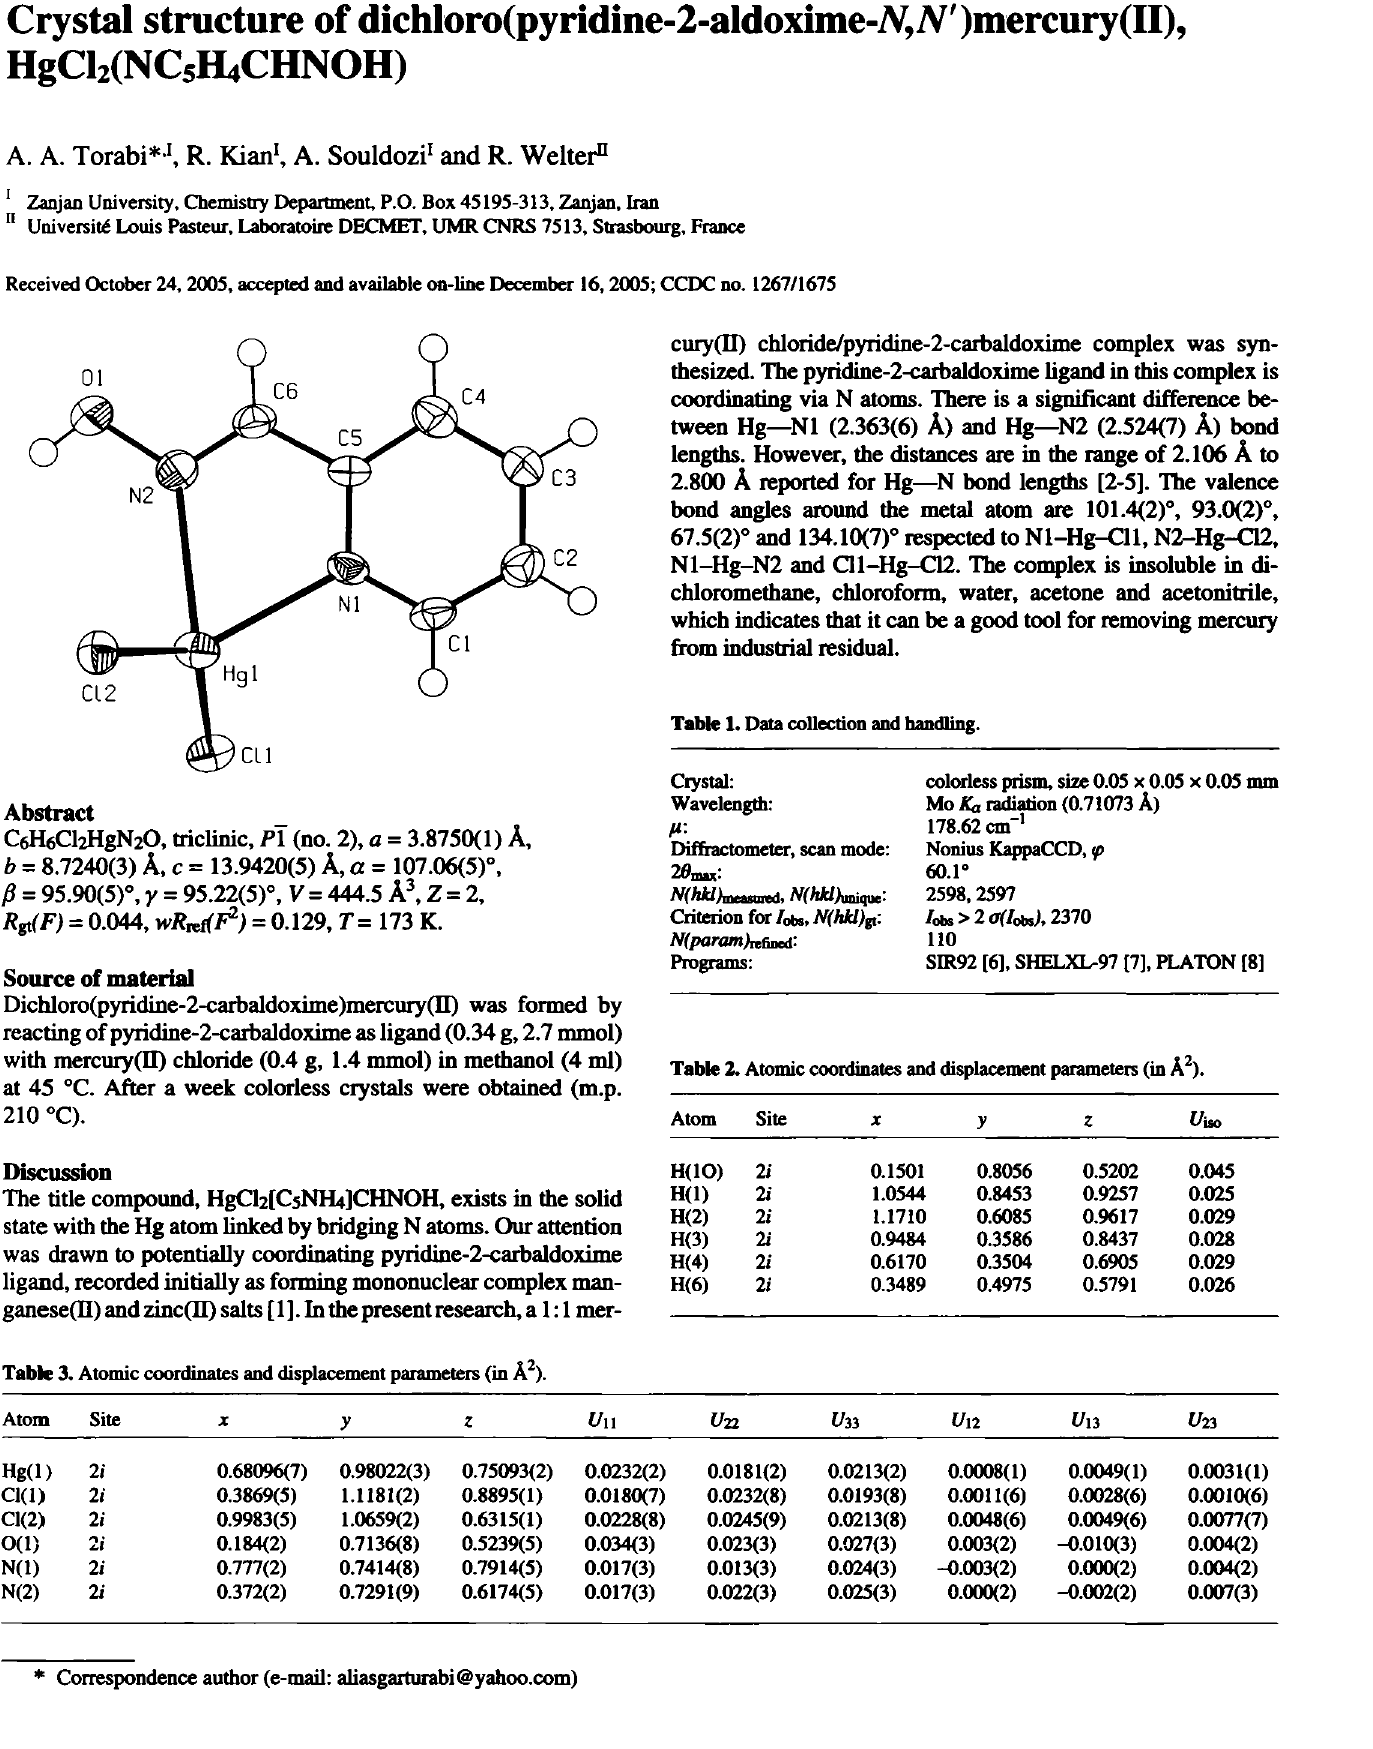
Table 3. Atomic coordinates and displacement parameters (in Ä 2 ).